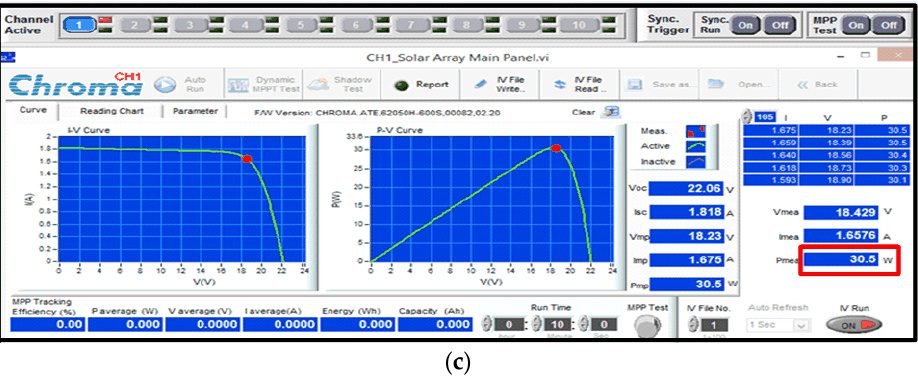
Figure 20. Modified LFO at 600 W/m 2 , ( a ), ( b ), ( c ) reflect same result.